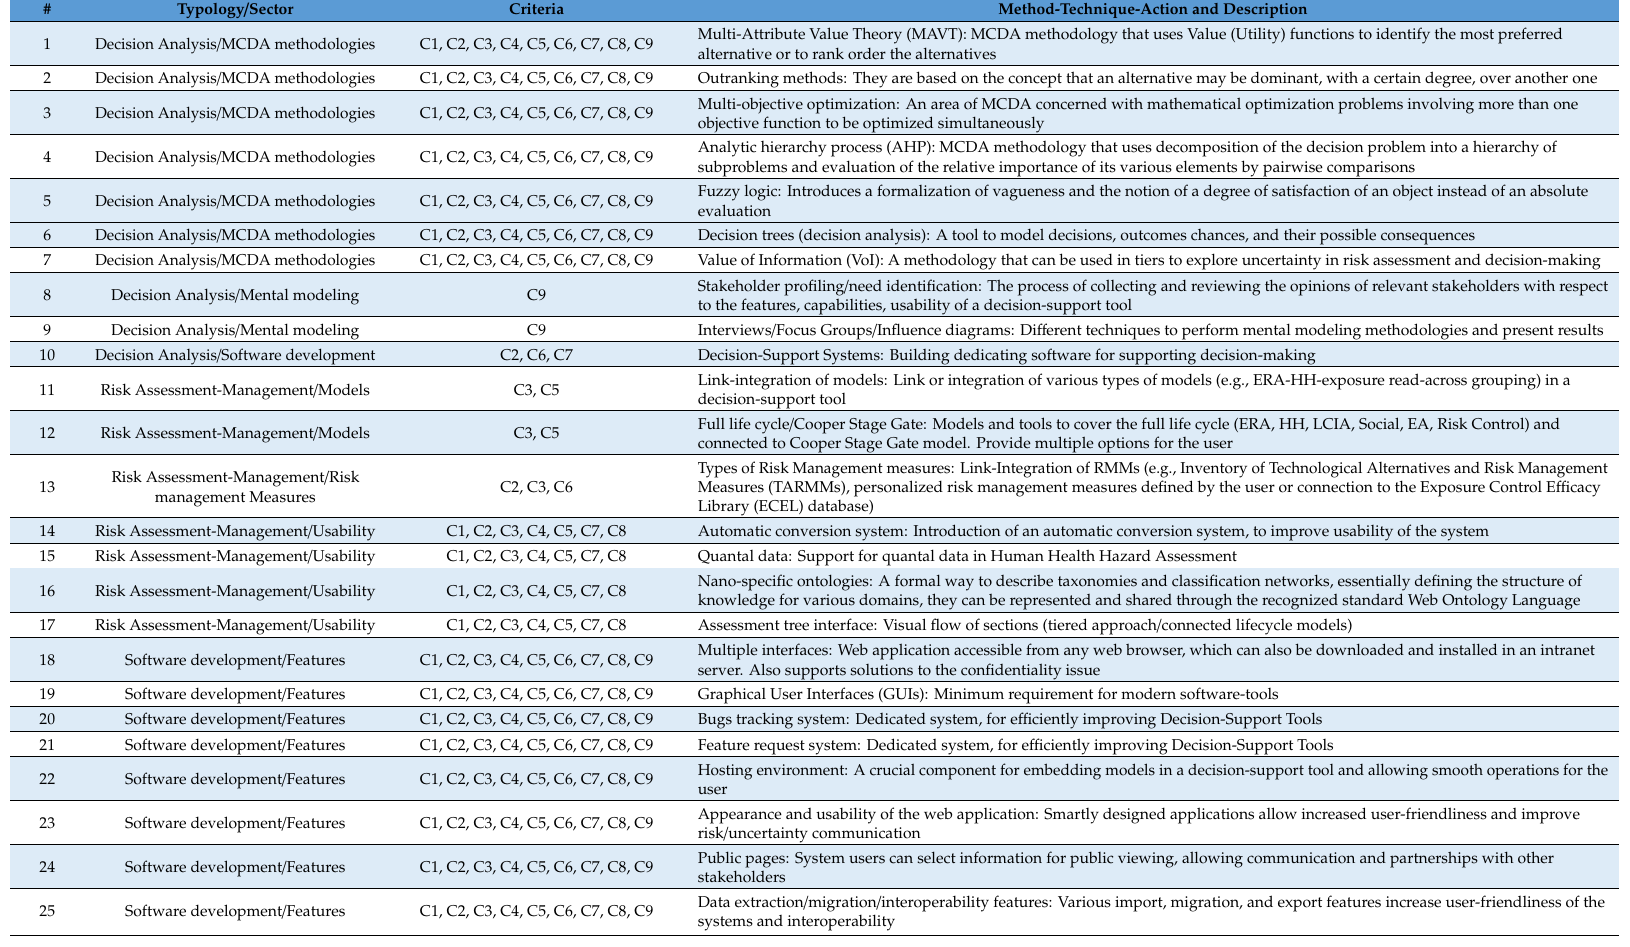
Table 5. Methods and techniques useful to implement the identified criteria in decision-support tools and